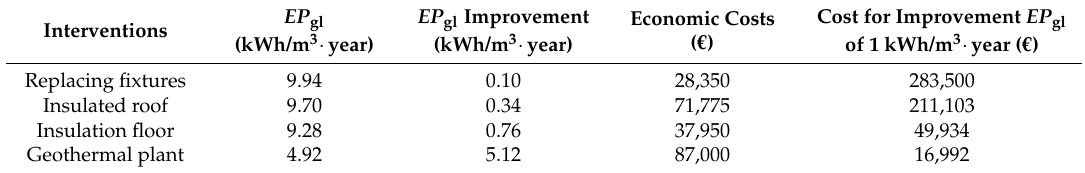
Table 11. Economic costs and EP gl improvement for each considered intervention in Villa Sciarra.